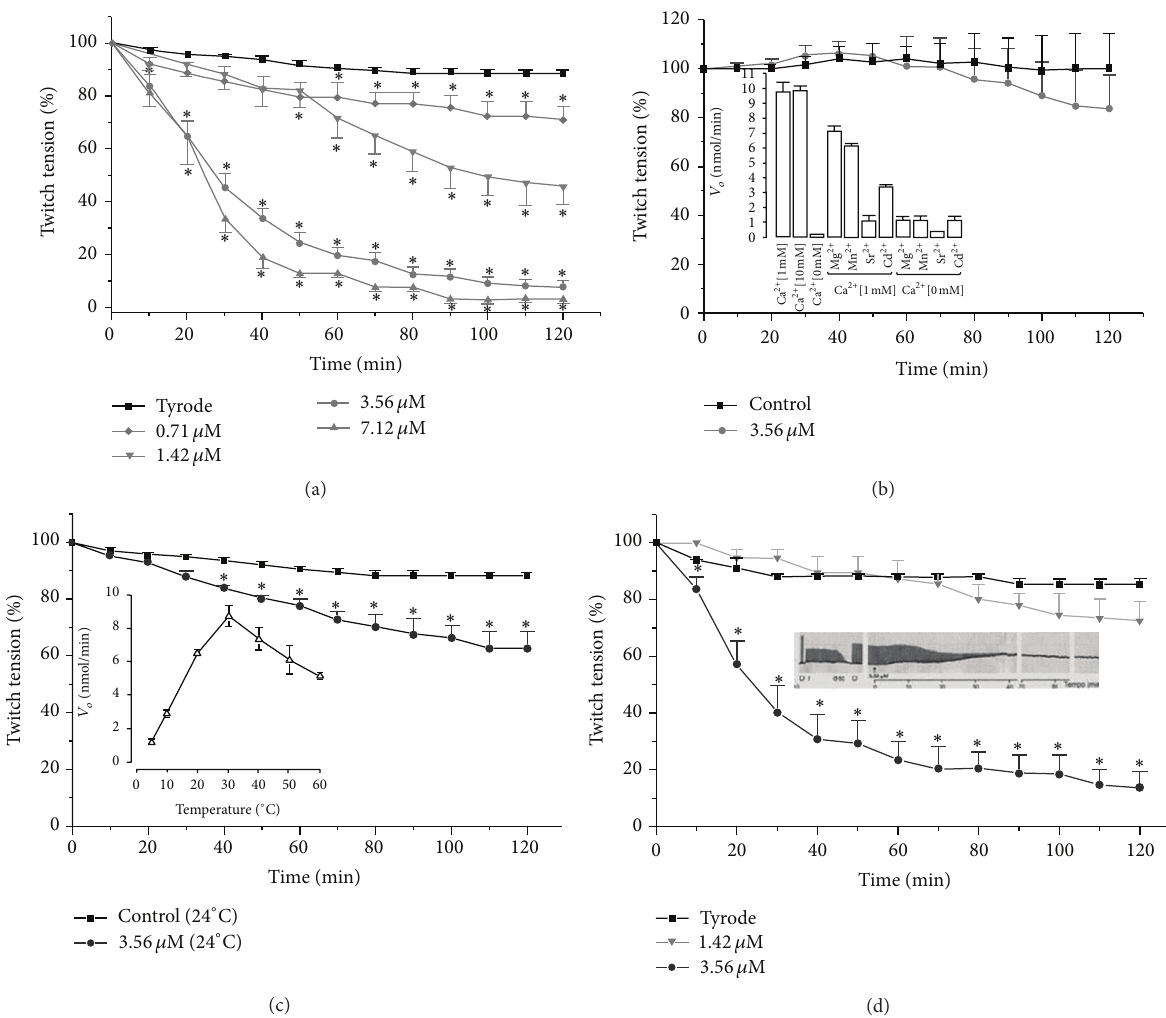
Figure 6: Twitch-tension response of direct and indirect stimulated PND preparations for 120 min. (a) The preparations were incubated with Tyrode (control) or Bp-13 PLA 2 (0.71–7.12 𝜇 M) at 37 ∘ C ( 𝑛 = 3 – 6 experiments); (b) twitch-tension response of PND preparations incubated with Bp-13 PLA 2 in Tyrode solution and in Tyrode whose 1.8 mM Ca 2+ was replaced by 4 mM Sr 2+ at 37 ∘ C ( 𝑛 = 4 – 6 ); (c) twitch-tension response of indirectly stimulated PND preparations incubated with Tyrode (control) or Bp-13 (3.56 𝜇 M) at 24 ∘ C ( 𝑛 = 4 – 6 experiments); (d) twitch-tension response of directly stimulated PND preparations incubated with Tyrode (control) or Bp-13 (1.42 and 3.56 𝜇 M) at 37 ∘ C ( 𝑛 = 4 – 6 experiments). Twin arrows represent the time of toxin addition. Each point represents the mean ± SEM; ∗ 𝑃 < 0.05 compared to control values. ANOVA and followed by Mann-Whitney test for comparison between two